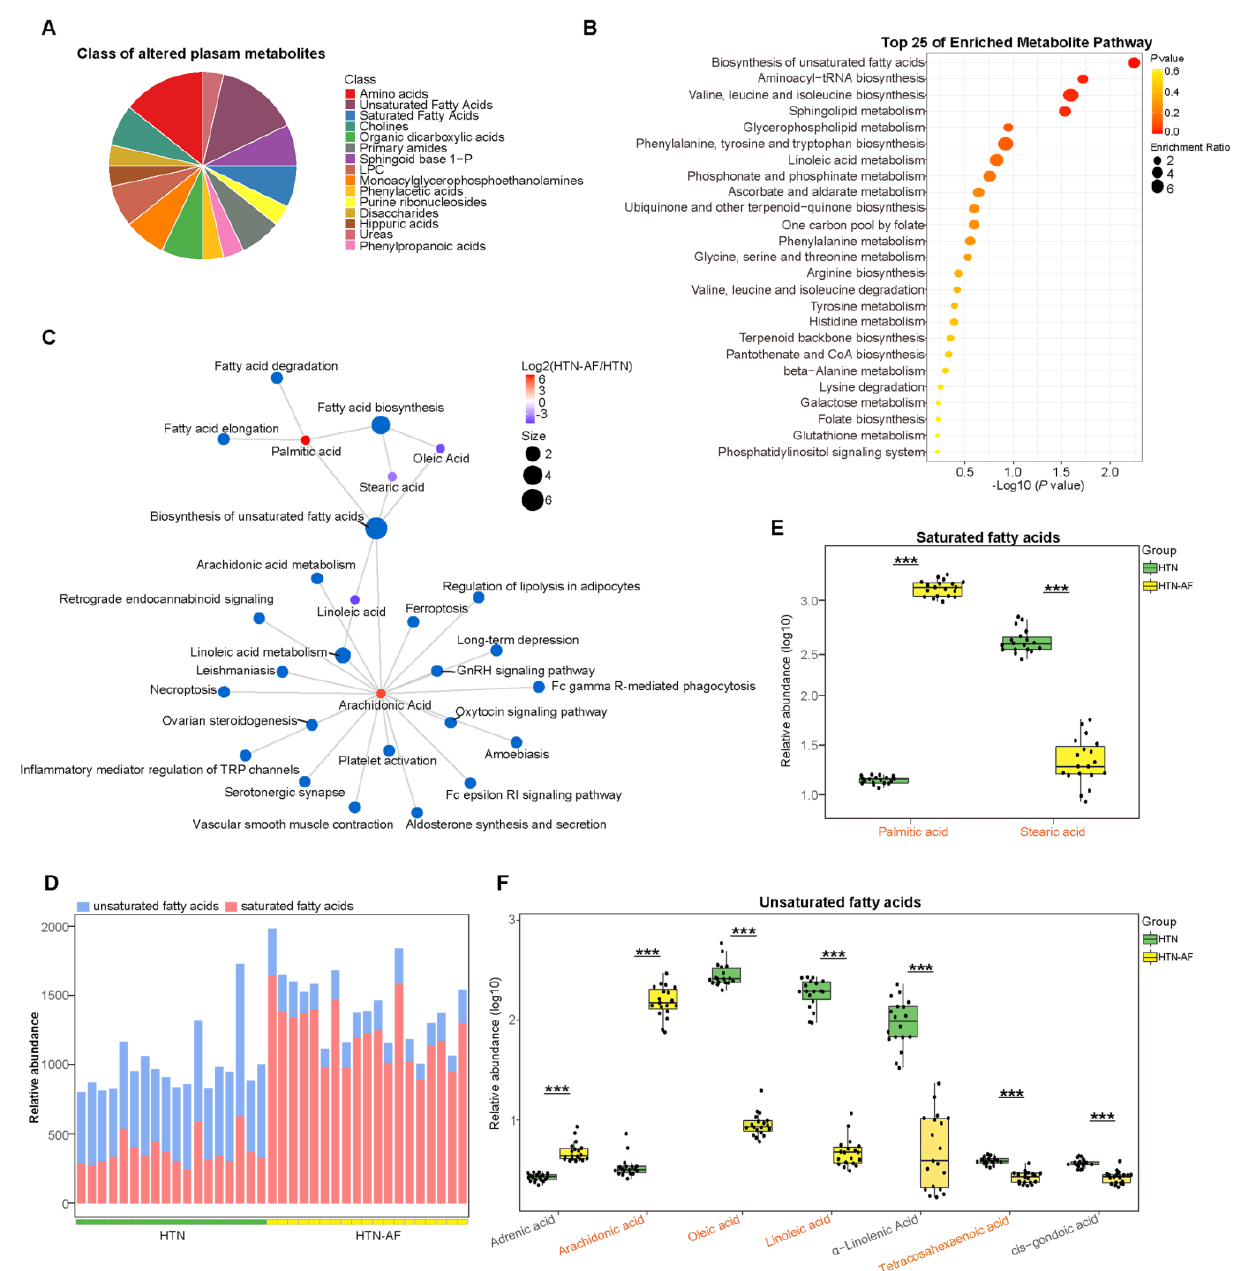
Figure 6. Aberrant distribution of saturated and unsaturated fatty acids in HTN-AF patients. ( A ) Pie chart depicting the class proportion of differential metabolites in the circulation of the subjects. ( B ) Bubble chart of top 25 pathway (class: metabolism) enrichment of distinct metabolites between the two groups. ( C ) Network chart illustrating the KEGG pathway (all classes) involved in differential fatty acids. ( D ) Stack graph showing the composition ratios of saturated and unsaturated fatty acids for participants. Blue, unsaturated fatty acids; red, saturated fatty acids. ( E ) Box plots showing the relative abundance of two saturated fatty acids, including palmitic acid and stearic acid, in the HTN (green) and HTN-AF (yellow) groups. t -test. ( F ) Box plots showing the relative abundance of seven unsaturated fatty acids, including adrenic acid, arachidonic acid, oleic acid, linoleic acid, α- linolenic aci d, tetracosahexaenoic acid, and cis-gondoic acid, in the HTN (green) and HTN-AF (yel- low) groups. t -test; orange-colored word, VIP > 1; *, p < 0.05; **, p < 0.01; ***, p < 0.001.